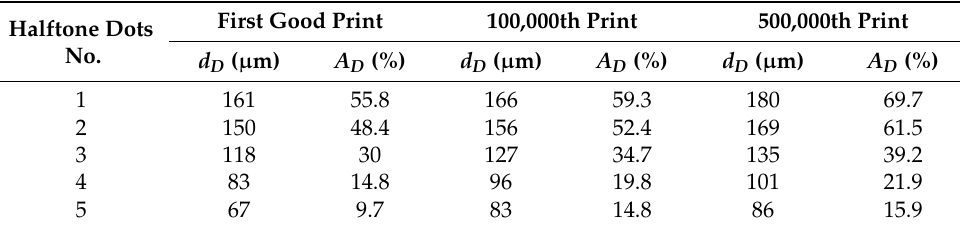
Table 2. Dot diameter ( d D ) and dot area ( A D ) of the selected dots at three stages of printing. Halftone Dots